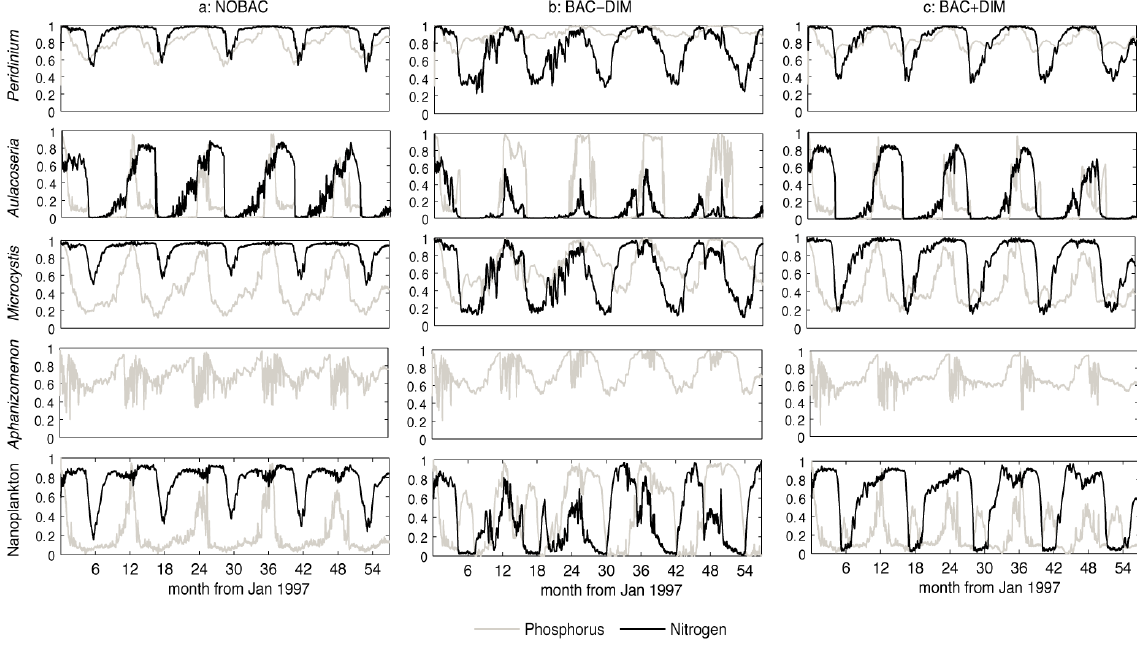
Figure 5. Comparison of nutrient limitation functions f a (N) and f a (P) respectively for the five simulated phytoplankton groups in a) NOBAC, b) BAC − DIM and c)